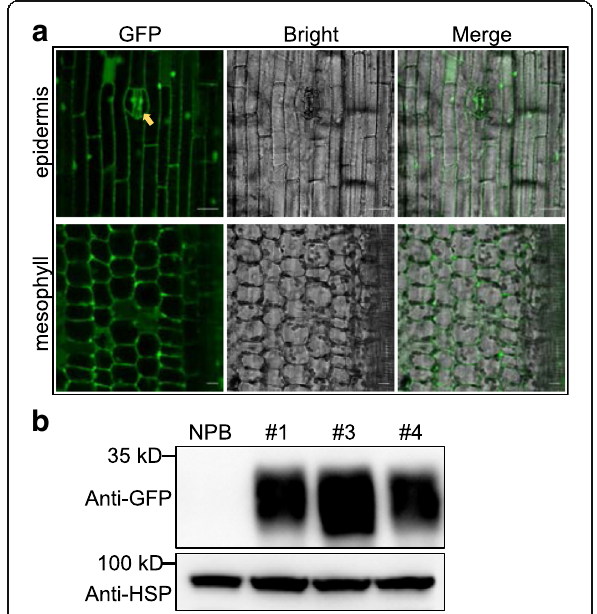
Fig. 4 Application of overexpression vectors in generating GFP transgenic rice. a GFP signals in transgenic line #1 tissues. The arrow indicates the stoma. Vector pRHVnGFP was used for generating transgenic rice plants by Agrobacterium -mediated transformation. Bar = 10 μ m. b Western blot detection of the GFP protein in transgenic lines. Three independent transgenic lines and the wild type were used for western blot detection. The HSP (heat shock protein) indicates the loading amount of each sample